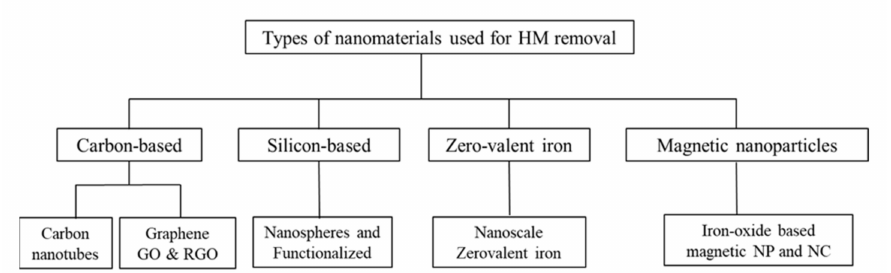
Figure 1. Nanomaterials for heavy metal remediation in aqueous